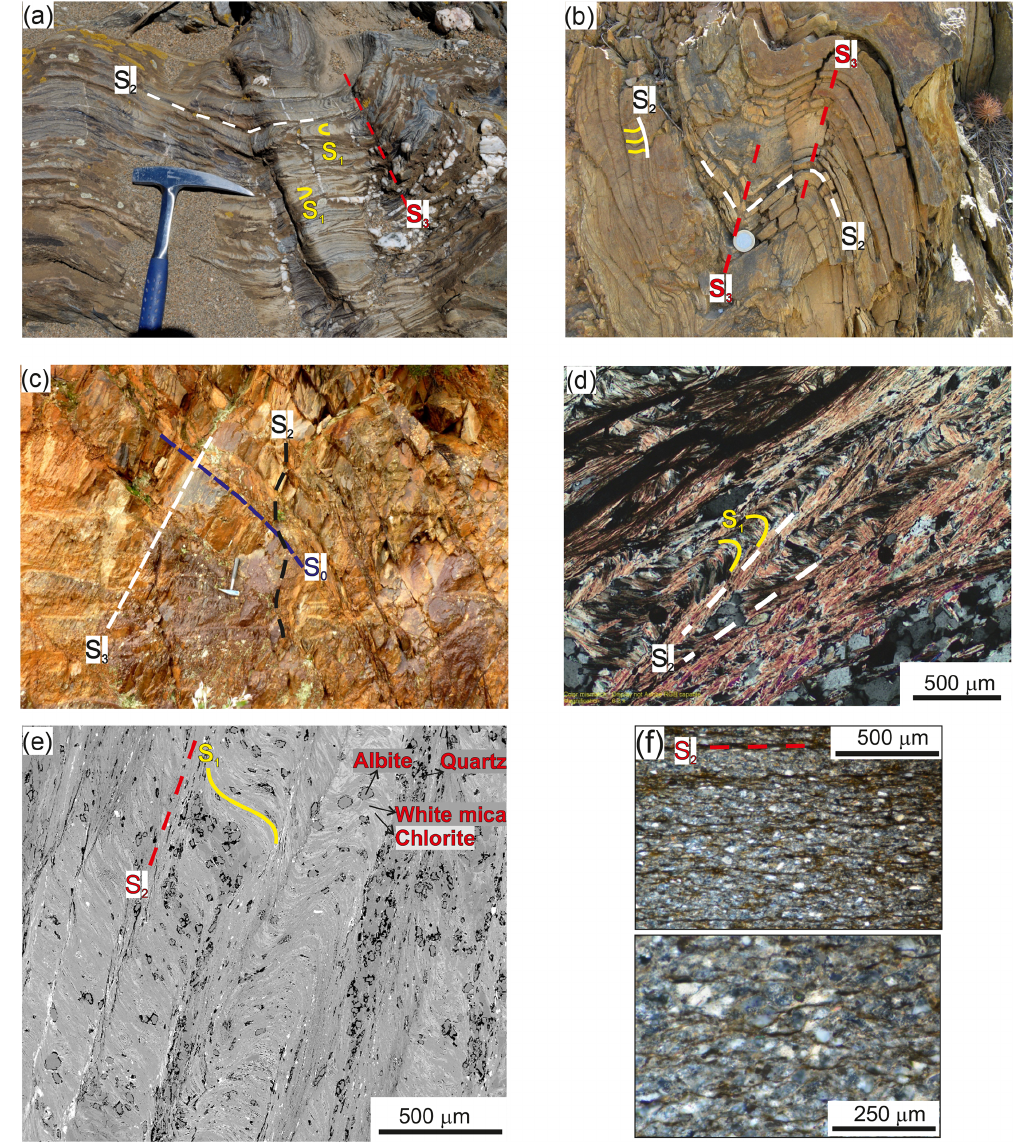
Figure 2. Pictures of the Pulo do Lobo rocks illustrating deformation at the outcrop scale: (a) Pulo do Lobo Formation, (b) Ribeira de Limas Formation, (c) Santa Iría Formation. Microphotographs from thin sections: (d) cross-polarized light image of sample PLB-84 (Pulo do Lobo Formation), (e) SEM–BSE (backscattered electron) image of sample PLB-88 (Ribeira de Limas Formation), (f) cross-polarized light images of sample PLB-71 (Santa Iría